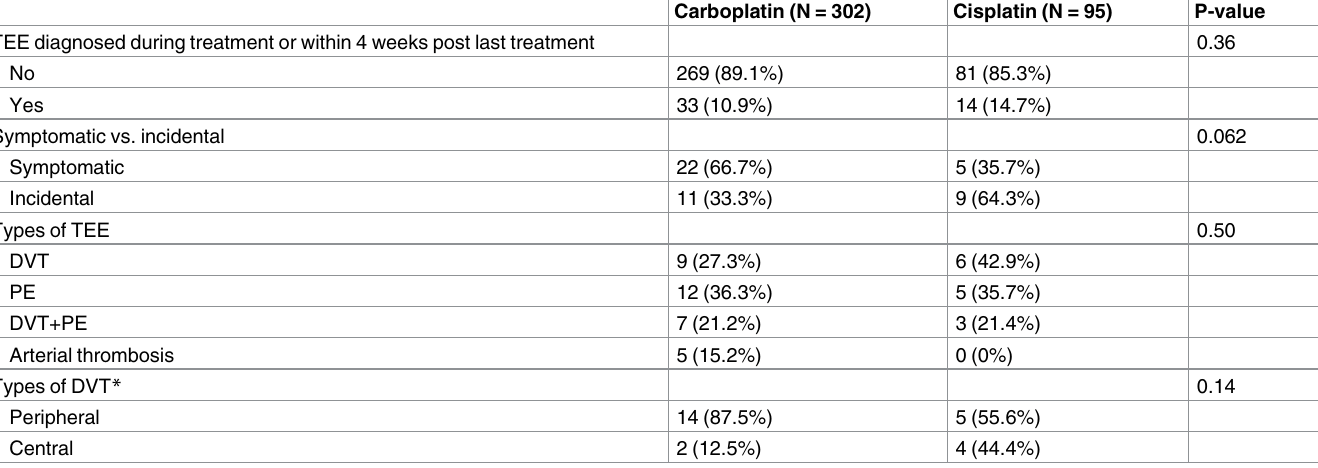
Table 2. Number (%) and types of thromboembolic events in carboplatin and cisplatin groups (N =